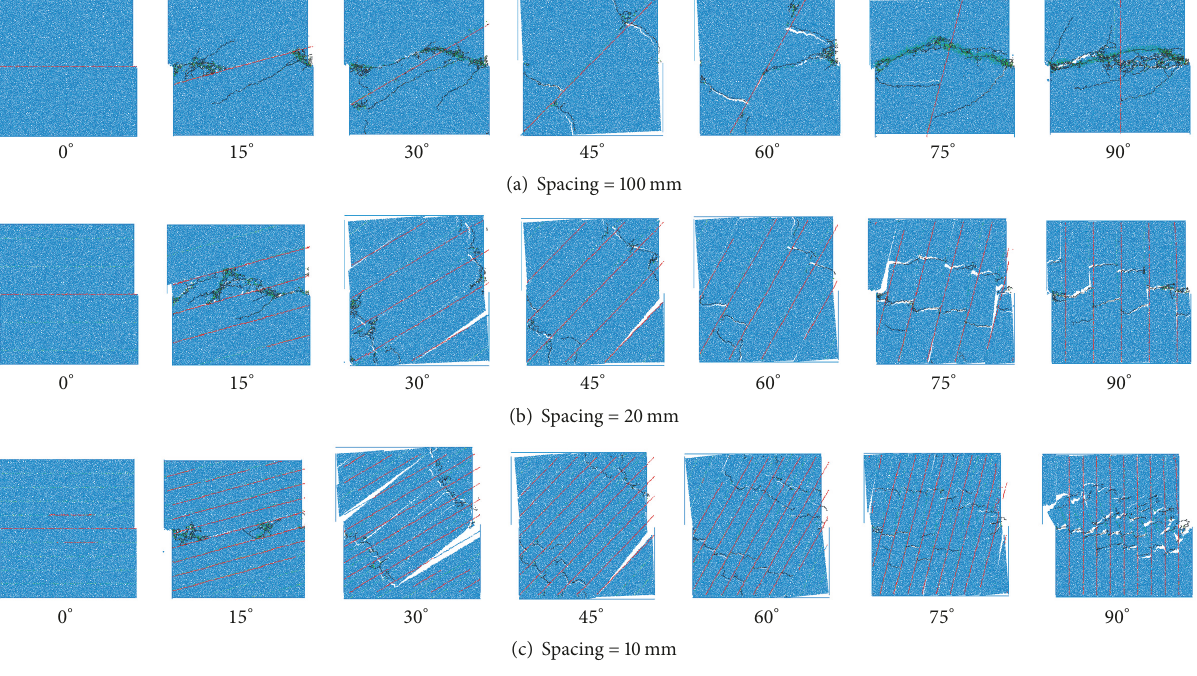
Figure 15: Failure of the numerical models in the direct shear tests.